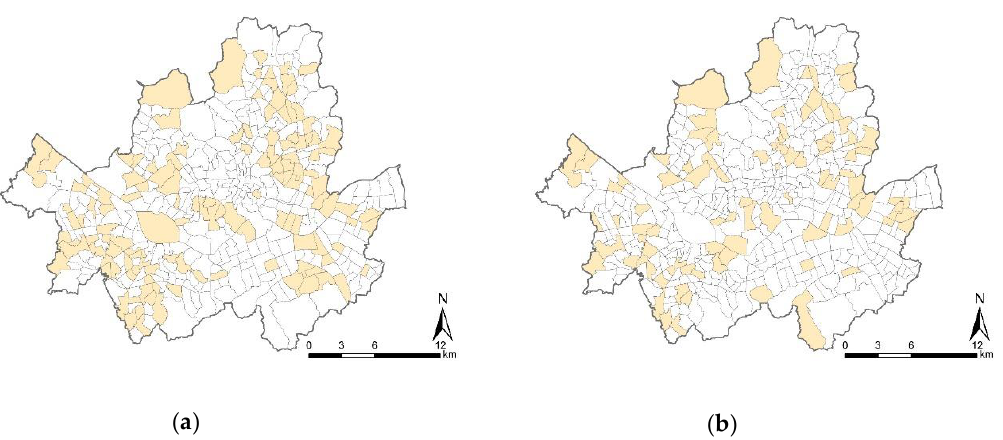
Figure 1. Study area: ( a ) Neighborhoods with at least 30 individual respondents for leisure trips (N = 129); ( b ) Neighborhoods with at least 30 individual respondents for shopping trips (N = 91).